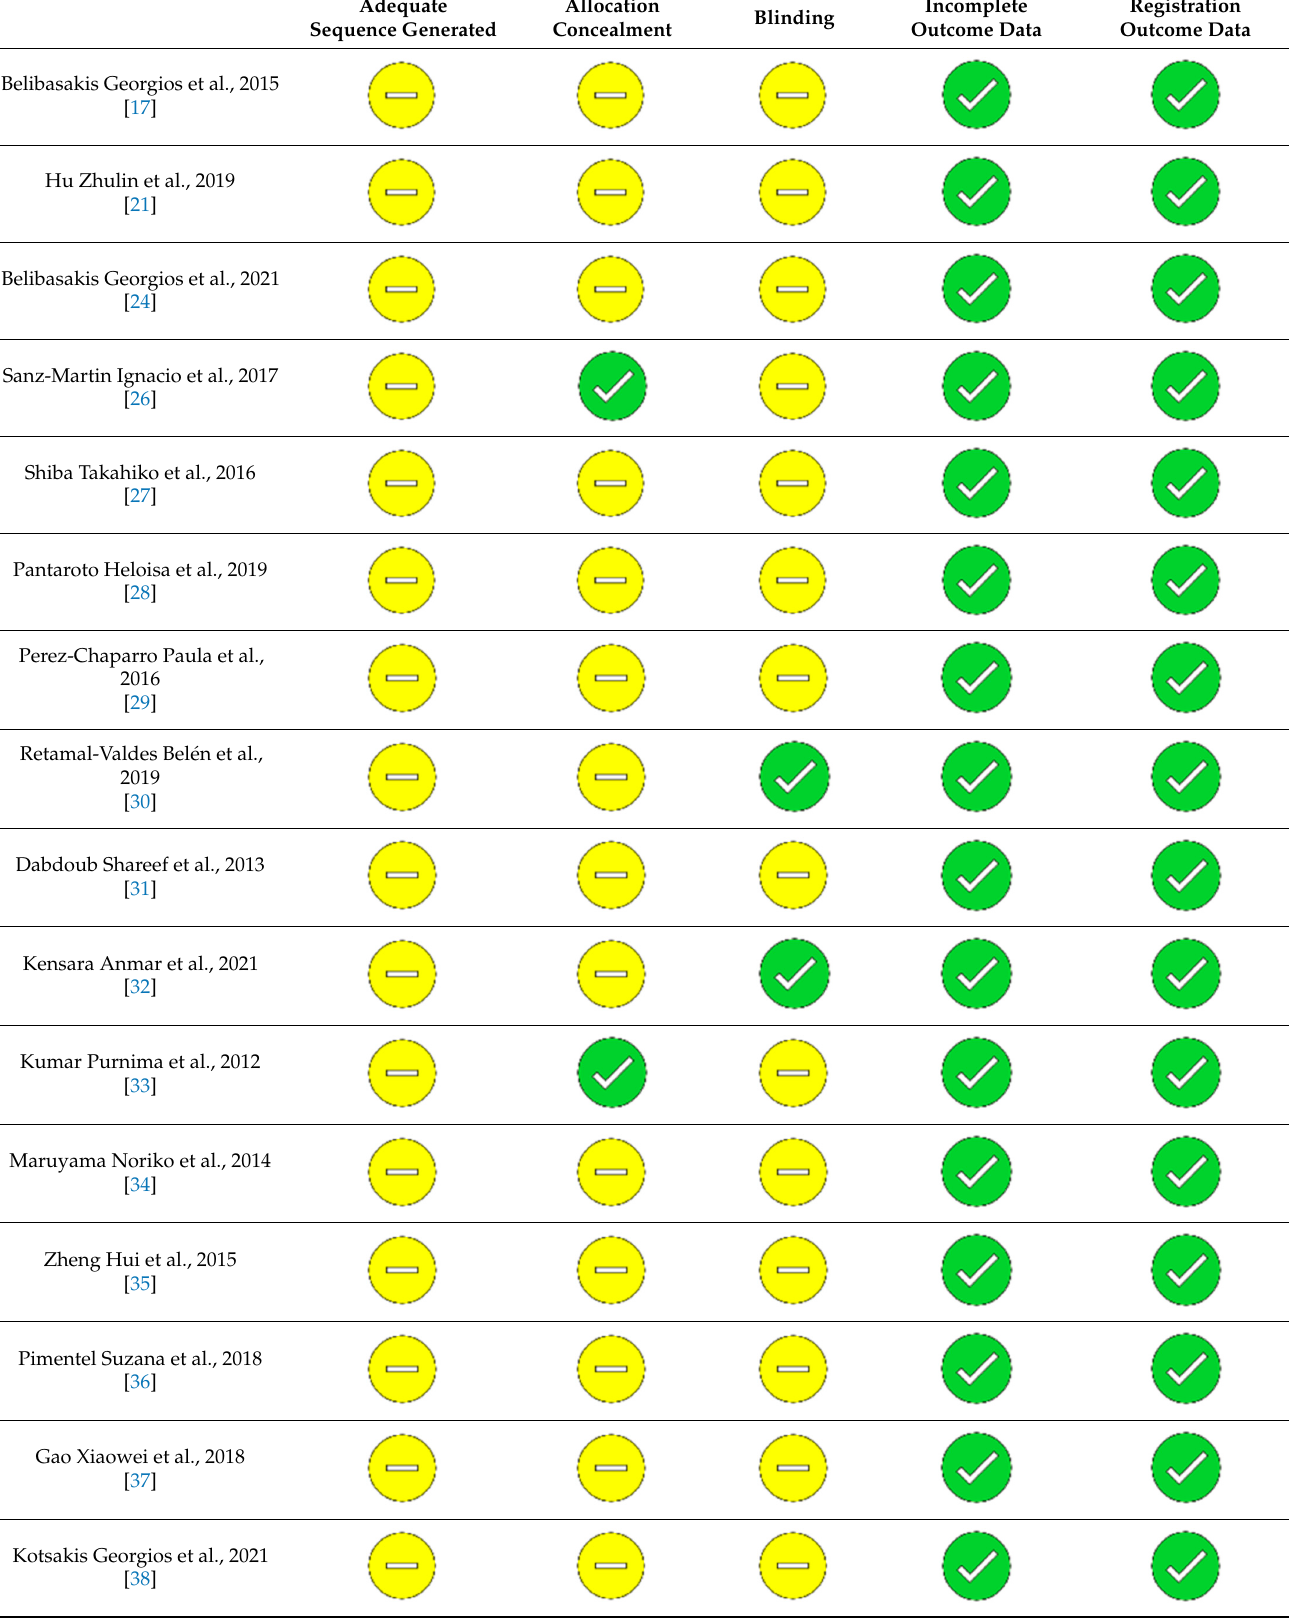
Figure 1. Number of research papers published until 2021.